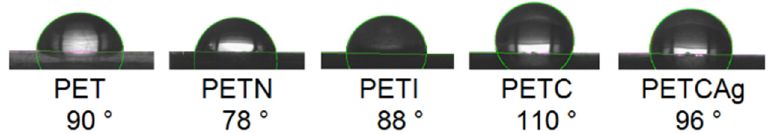
Figure 3. Contact angle of superficially modified films.